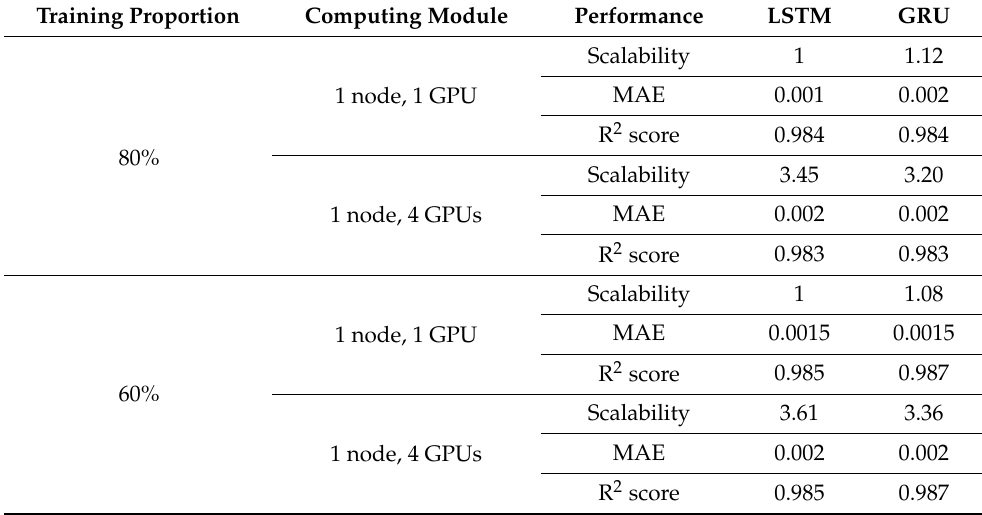
Table 1. Evaluation of the LSTM and the GRU model on DEEP-DAM module on one node and several